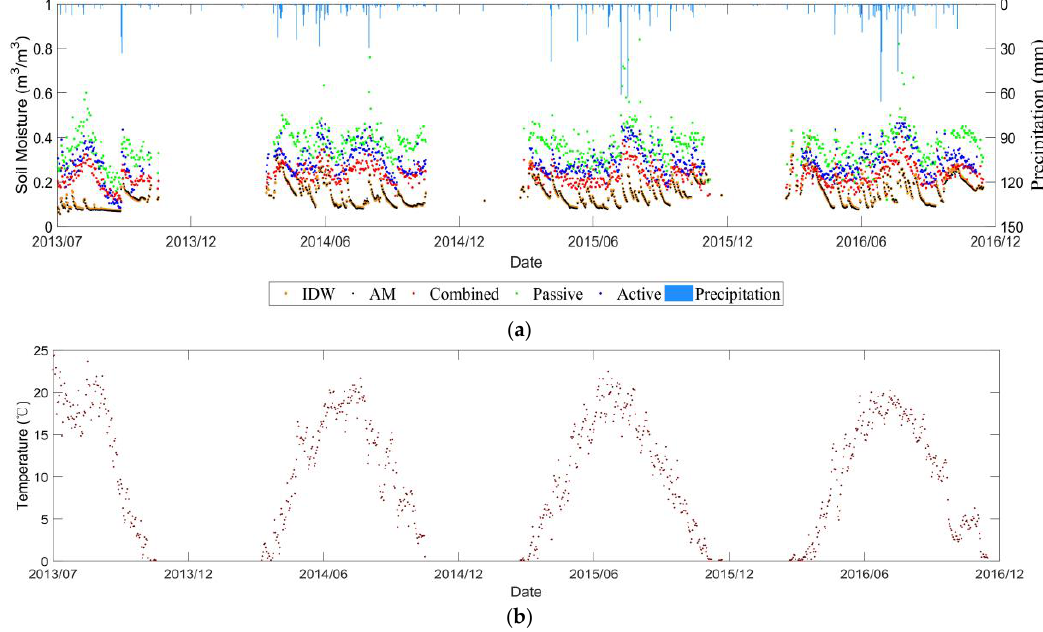
Figure 12. Temporal evolutions of ( a ) CCI retrieved and in-situ measured soil moisture ( b ) temperature over Saskatchewan site in the RISMA network.